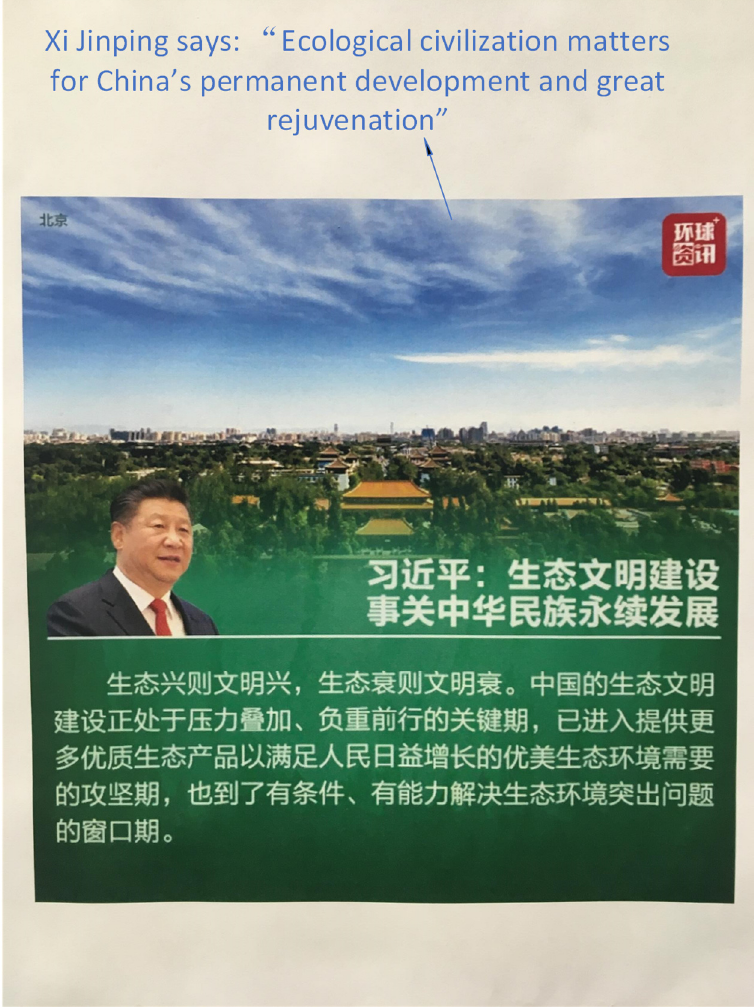
Figure 6. Government billboard promoting ecological civilization as China’s green deal to enhance the nation’s reputation and contribute to its global leadership (source © authors). Translation: Xi Jinping says: “Ecological civilization matters for China’s permanent development and great rejuvenation. Improved ecological conditions bring us a more civilized society. We are now facing severe stress on the way to achieving ecological civilization but I believe that China has the ability to sort out any challenges we meet.” (photo© authors).